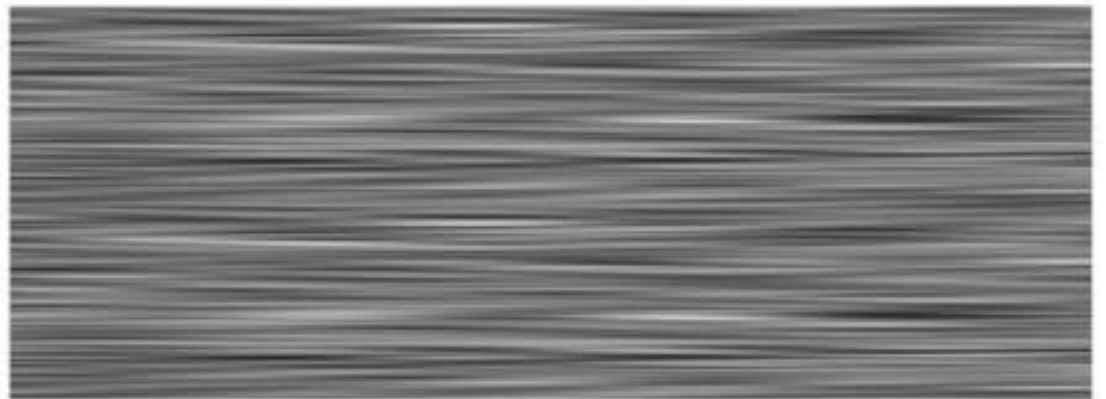
Figure 7. Graphic of the muscle function g(x,y) used on the simulation model. Gray scale indicates the properties of spatial variation for the simulation of muscle fibers.